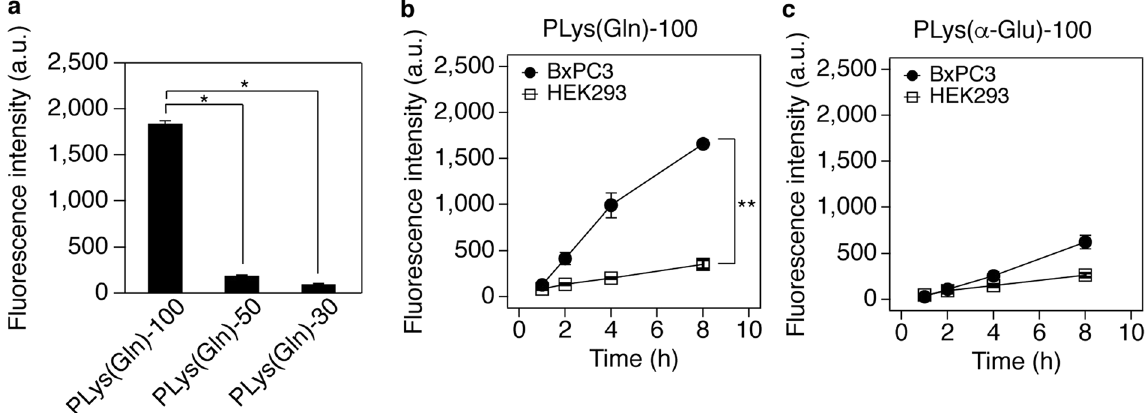
Figure 3. Cellular uptake analysis of the polymers. ( a ) Cellular uptake analysis in BxPC3 cells after 3 h incubation with the polymers. Data are mean ± S.D. (n = 3). p * < 0.001 (one-way ANOVA with Tukey’s multiple comparison test). ( b , c ) Time-dependent cellular uptake analysis of PLys(Gln)-100 ( b ) and PLys( α -Glu)-100 ( c ) in BxPC3 and HEK293 cells. Data are mean ± S.D. (n = 3). p ** < 0.001 (two-way ANOVA with Tukey’s multiple comparison test).